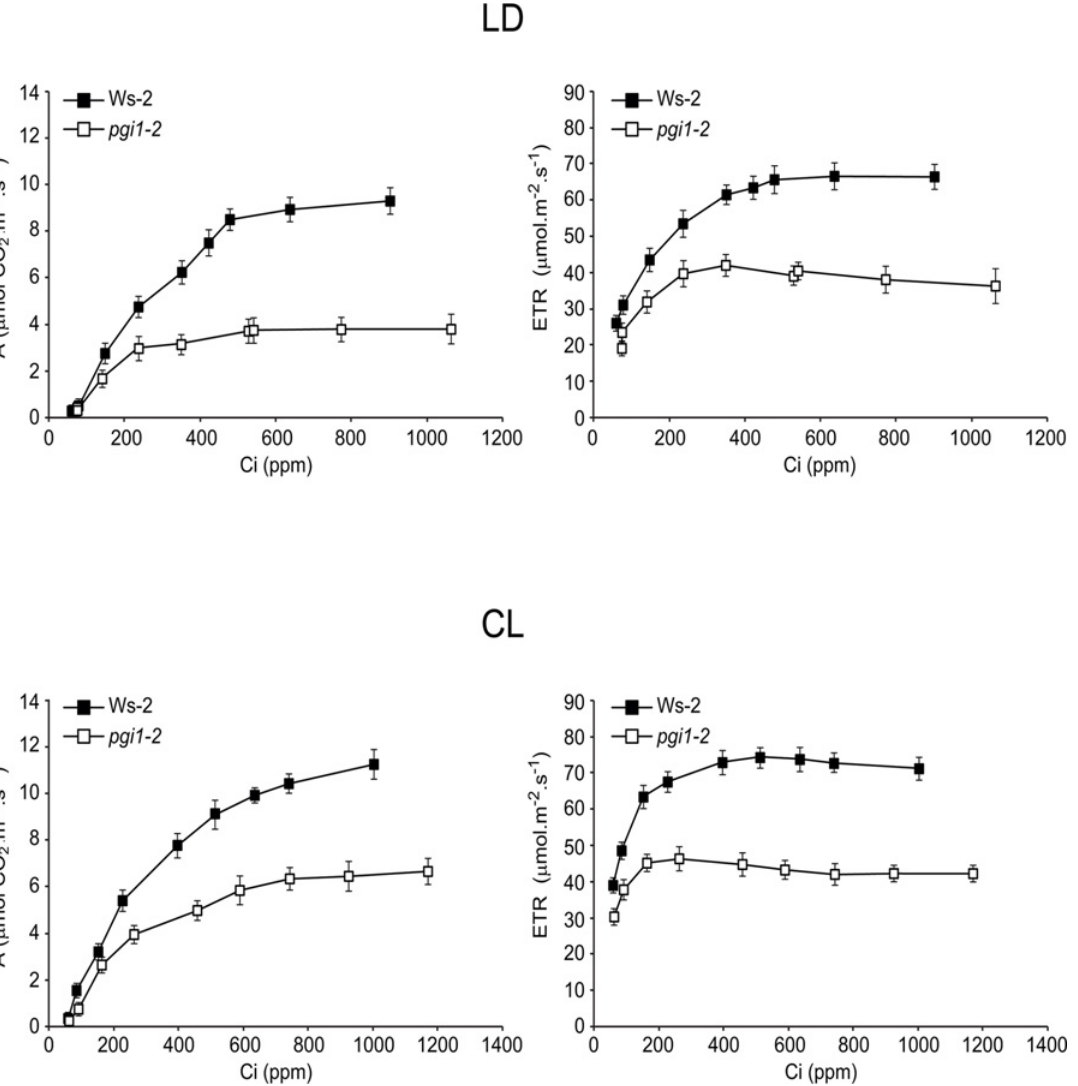
Fig 11. pgi1 – 2 leaves have reduced photosynthetic capacity and ETR. (A) CO 2 assimilation rates, and (B) photosynthetic electron transport at different intercellular CO 2 concentrations in WT and pgi1 – 2 source leaves. Plants were cultured on soil under LD conditions. Values represent the mean ± SE (n =